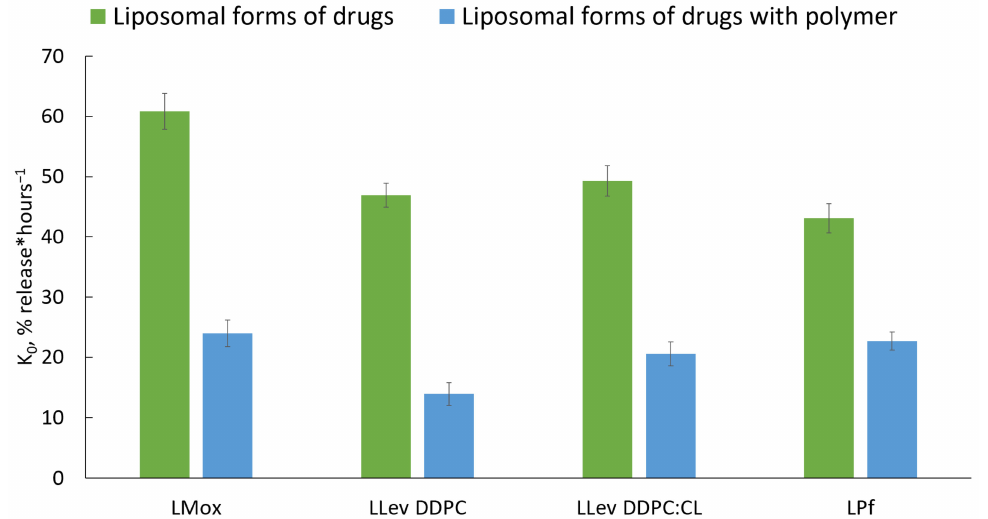
Figure 9. Zero-order kinetic constants of drug release from liposomal forms with (blue) and without (green) a polymer shell. Liposomal formulations: LMox DPPC:CL 80:20, LLev DPPC, LLev DPPC:CL 80:20, and LPf DPPC:CL 80:20 and its complexes with mannosylated chitosan, base–molar ratio 1:7. Total lipid concentration was 3 mg/mL in 0.02 M Na phosphate-buffered solution, pH 7.4. 37 ◦ C. SD ( n = 3), p <